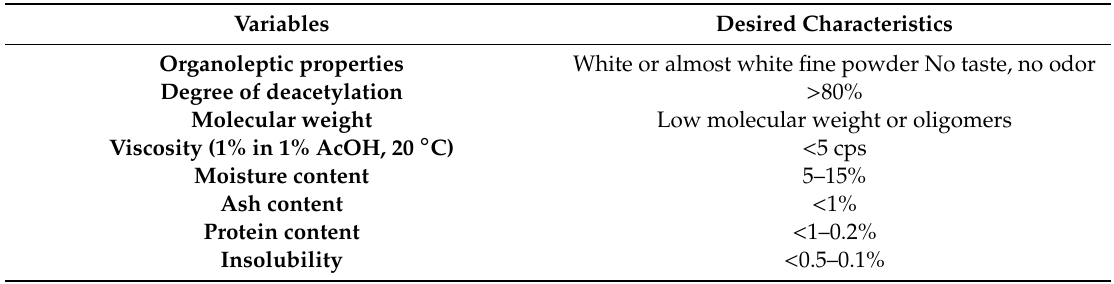
Table 1. Summary of Chitosan characteristics for medical